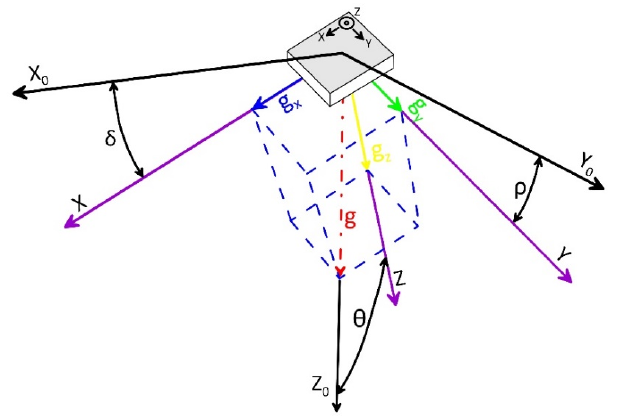
Figure 1. Flow chart showing the logic of the code of the single module prototype.